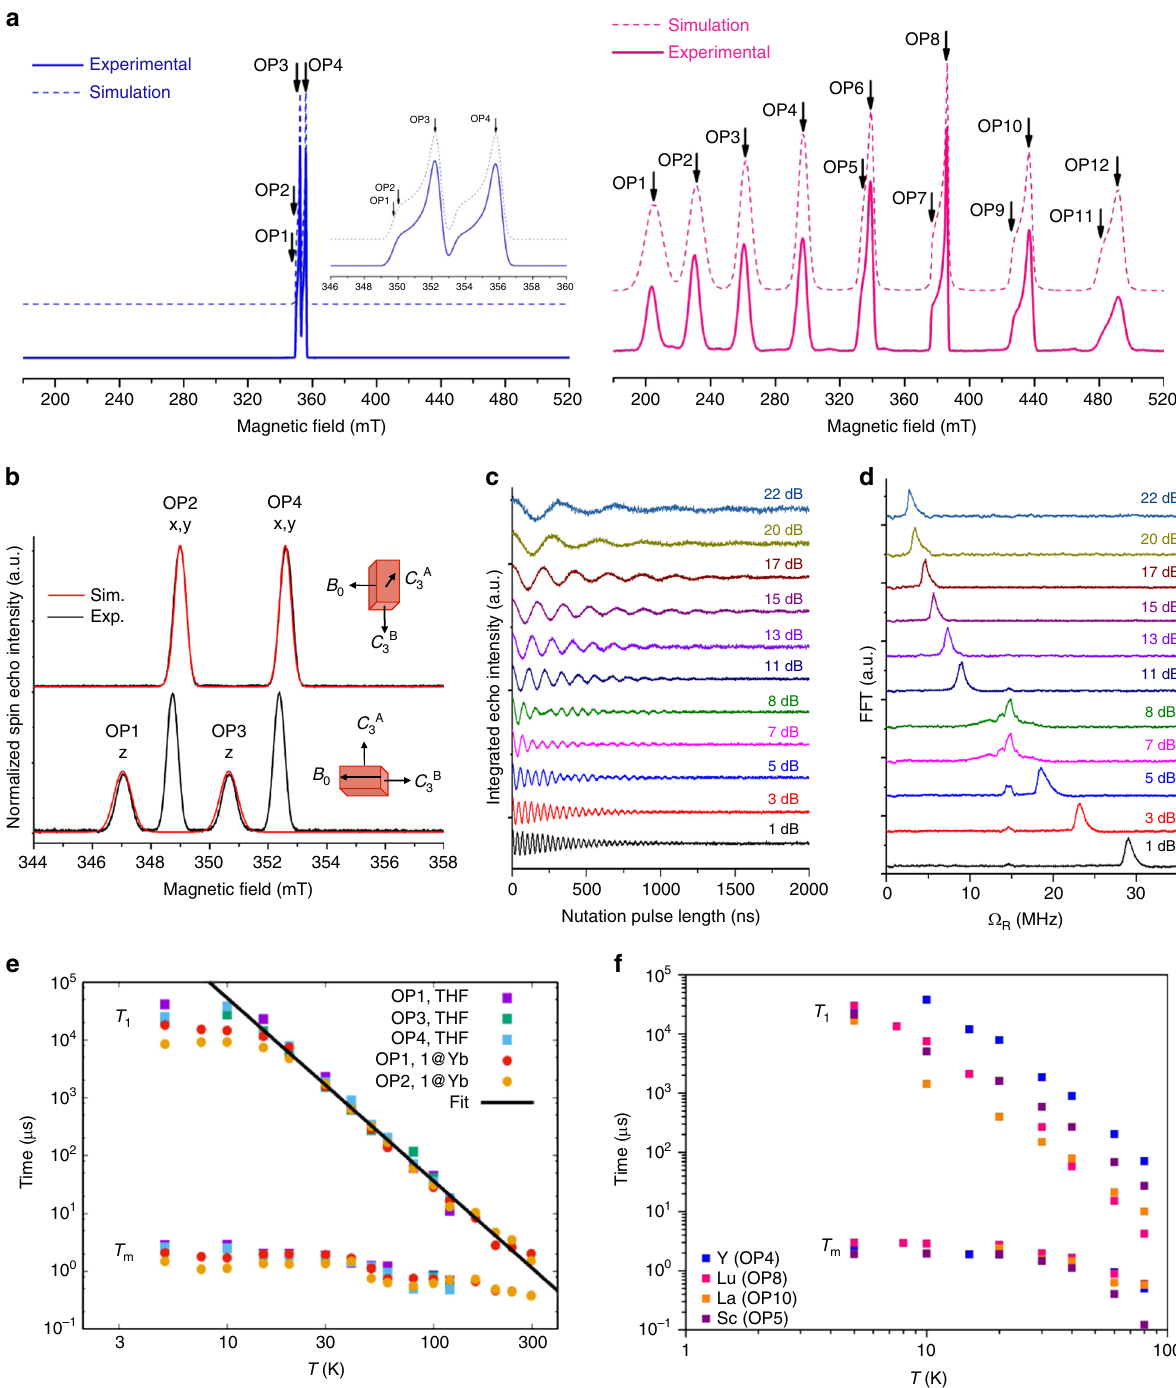
Fig. 2 Echo-detected fi eld-swept EPR spectra. Experimental (full) and simulated (dashed) EDFS spectra at 50 K and X-band (9.85 GHz) for a 10 mM THF solution of compounds 1 (blue) and 2 (pink), with the parameters in Table 1. b Experimental (black) and calculated (red) EDFS spectra at 200 K and X-band (9.75 GHz) for a single crystal of 1@5 at two selected orientations (Supplementary Figs. 3 and 4). Simulations are only for molecule B , such that only the resonances along the z-axis for molecule B are simulated in the lower fi gure (see Supplementary Methods for de fi nition of molecule B ). c , Rabi oscillations for 1@5 at 298 K and B 0 = 347 mT (OP1), acquired with different microwave attenuations (Supplementary Tables 5 – 9); d Fourier transforms of nutation data in c , giving the Rabi frequency (the 15 MHz signal is due to 1 H ESEEM). e Relaxation times measured by pulsed EPR methods for 1 in two phases (frozen THF solution and single crystal 1@5 ); black line is a simultaneous fi t of all the T 1 data above 20K with T 1 = C − 1 T − n where C = 1.3(3) × 10 − 8 μ s − 1 K − n and n = 3.16(5) (Supplementary Tables 1 – 4). f T 1 and T m dependence to 100 K for a single representative orientation of 1 , 2 , 3 and 4 . Observer positions OP1-OP12 mark the magnetic fi elds where time-dependent pulsed EPR experiments were